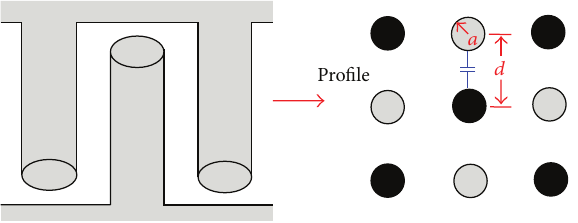
Figure 5: Equivalent circuit developed by Qu and Shi.